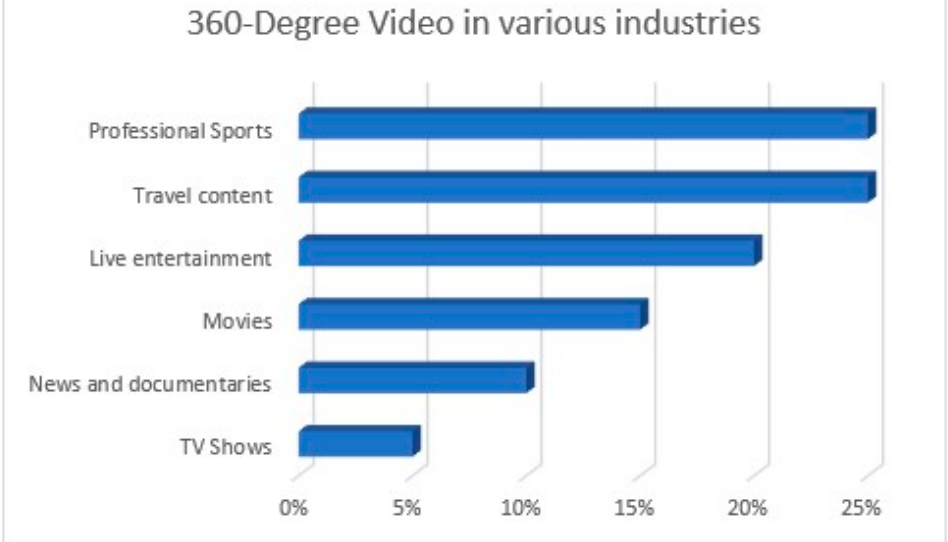
Figure 1. Growth of the 360-degree video in various industries.